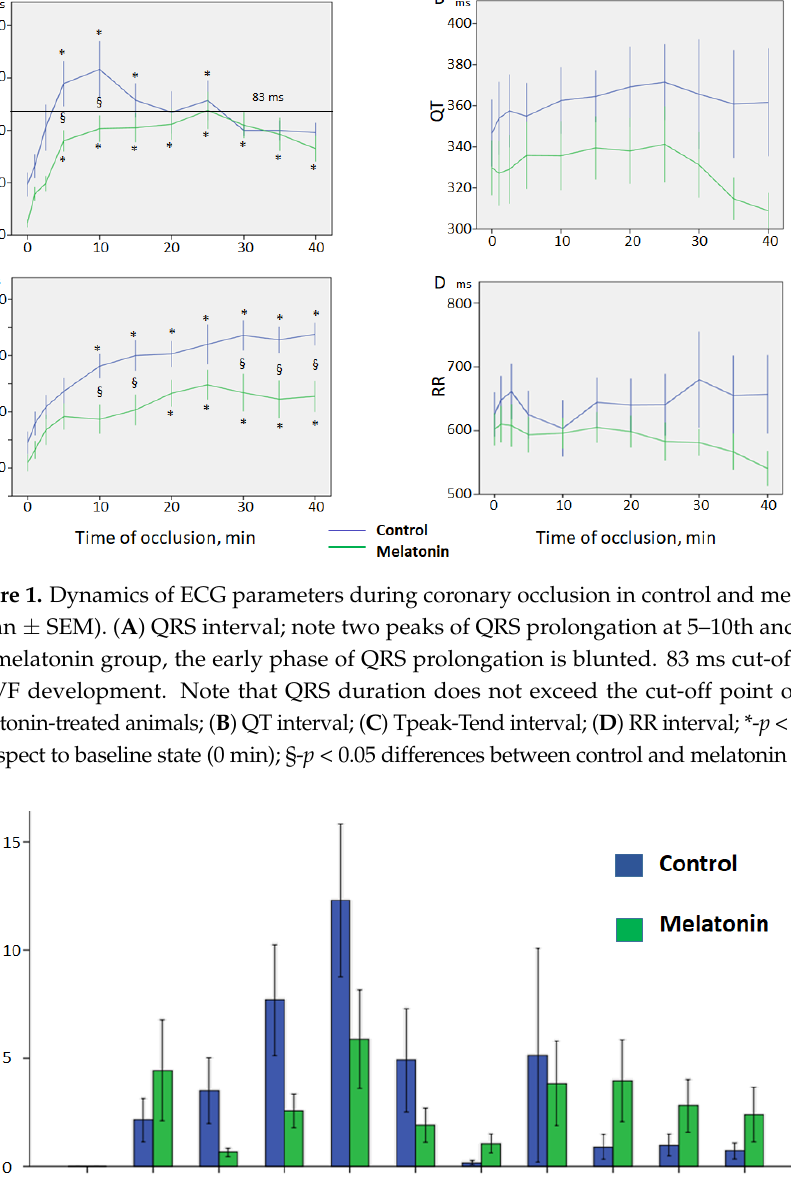
Figure 3. ROC curve analysis of association between QRS duration and VF development. 3. Discussion The present study demonstrated that melatonin mitigated the ischemia-related prolongation of the QRS complex in the early period of ischemia and that this effect was associated with prevention of the early ischemic VF. Melatonin has been reported to be a promising cardioprotective and antiarrhythmic agent. Numerous experimental studies using either isolated hearts, cardiomyocytes, or an in vivo model showed attenuation of the ischemia/reperfusion-induced myocardial damage and reduction in the incidence of arrhythmias [8,9,14,15,21]. The protective effects of melatonin involve its antioxidant properties [32] as well as receptor-mediated actions [14,15].